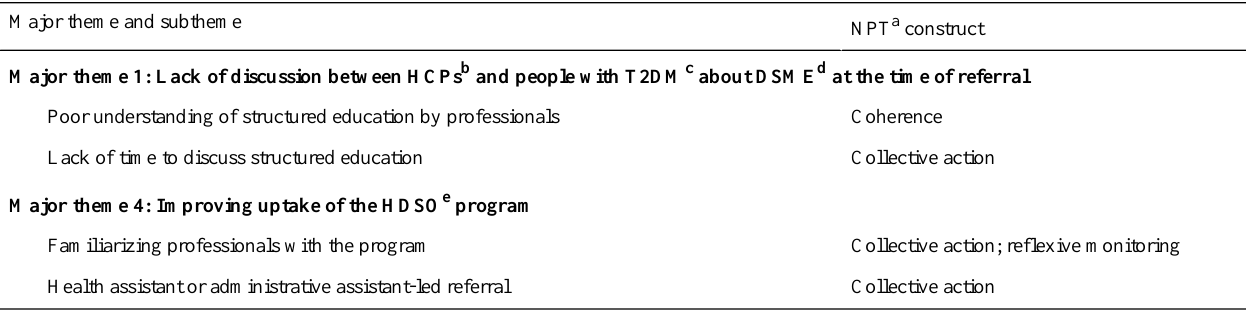
NPT a constructMajor theme and subtheme